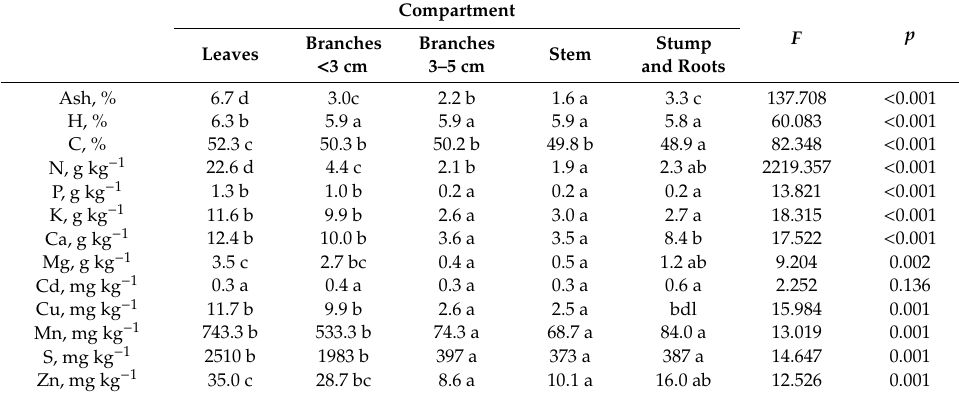
Table 2. Ash, H, C, and nutrient contents of rubberwood compartments. F -values and their significance ( p ). Means marked with the same letters within a row do not di ff er from each other at a significance level of p < 0.05 according to Tukey’s